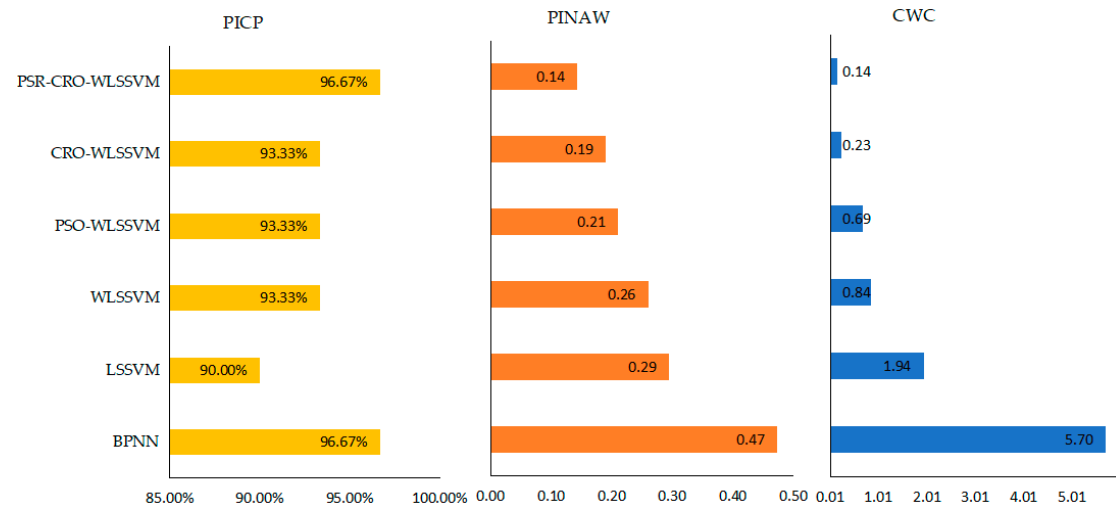
Figure 8. Value of prediction interval coverage probability (PICP), prediction intervals normalized averaged width (PINAW), and coverage width-based criterion (CWC) for forecasting intervals of six models based on time series of H 2 from 10 July 2012 to 8 August 2012.